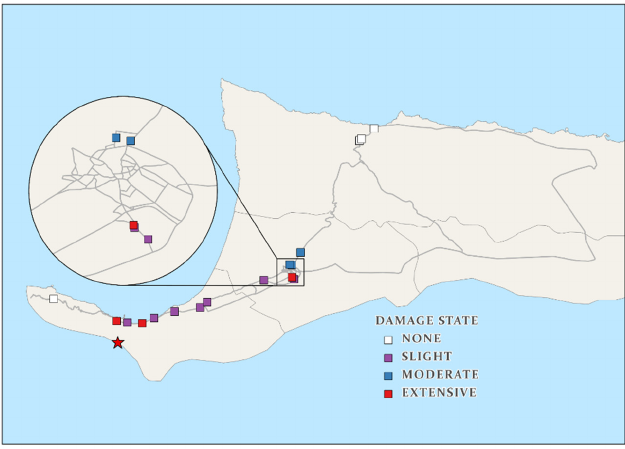
than HWB3. Therefore, for the same level of IM, HWB8 experiences a higher damage state